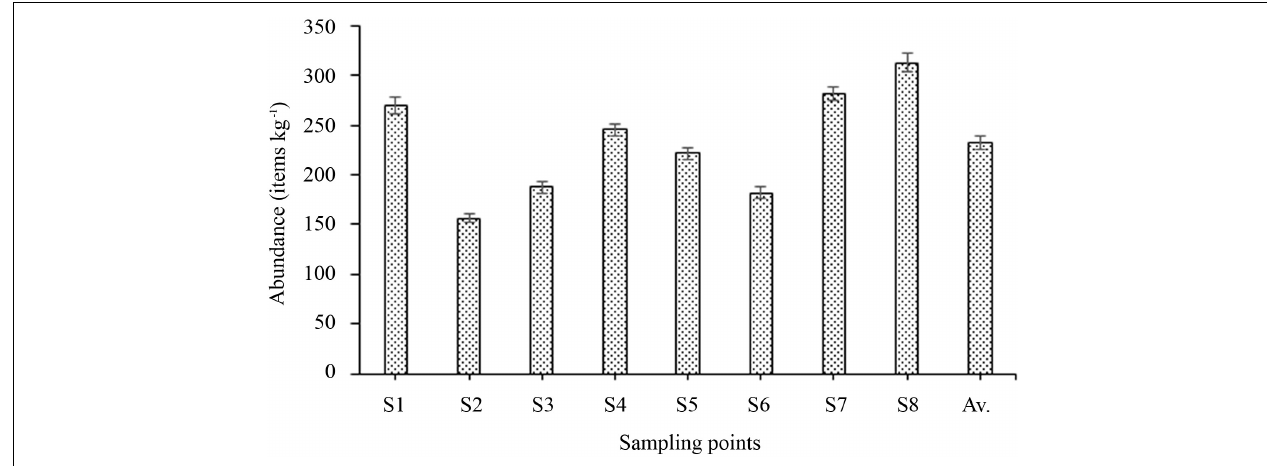
FIGURE 2 | The abundance of microplastics (MPs) in different sampling points.